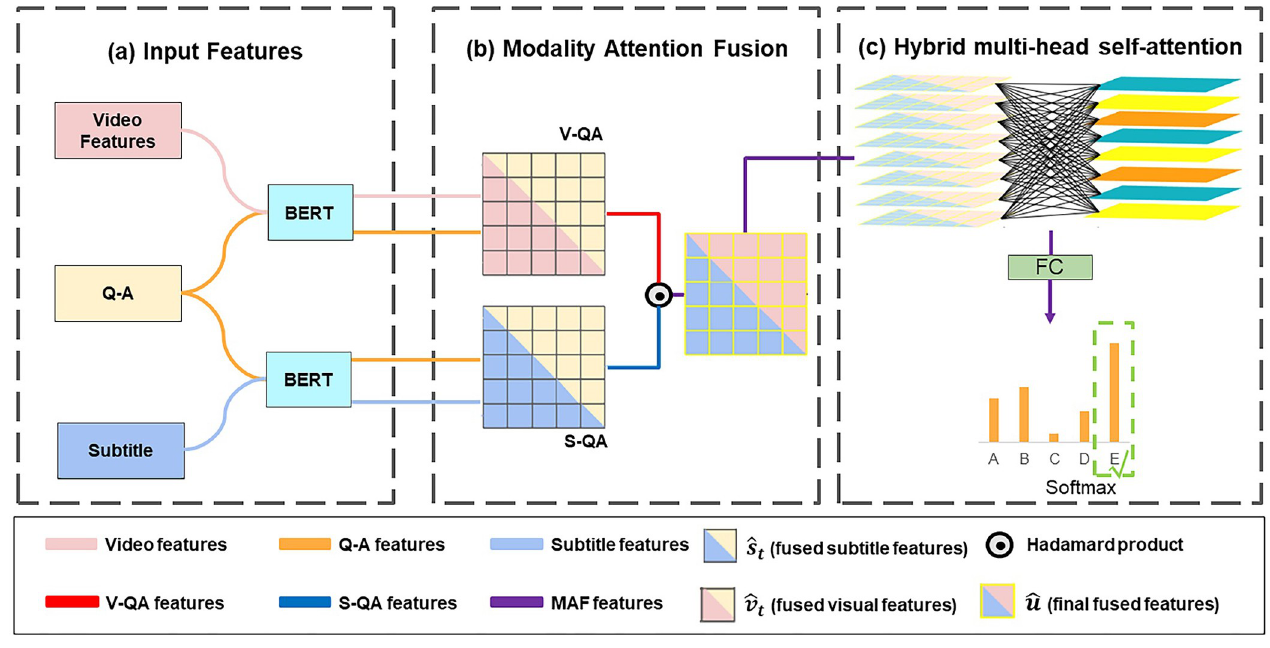
Fig 2. The network architecture of